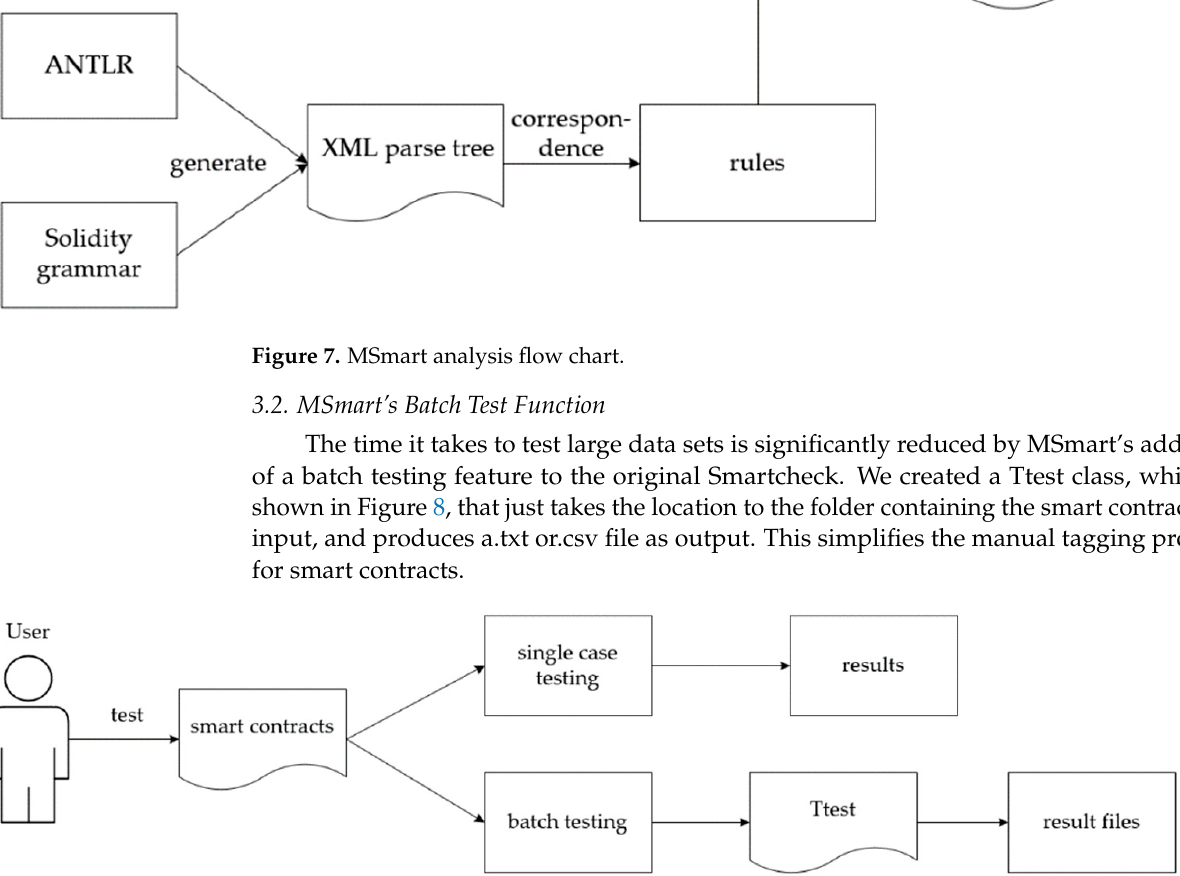
Figure 8. Introduction of Ttest.